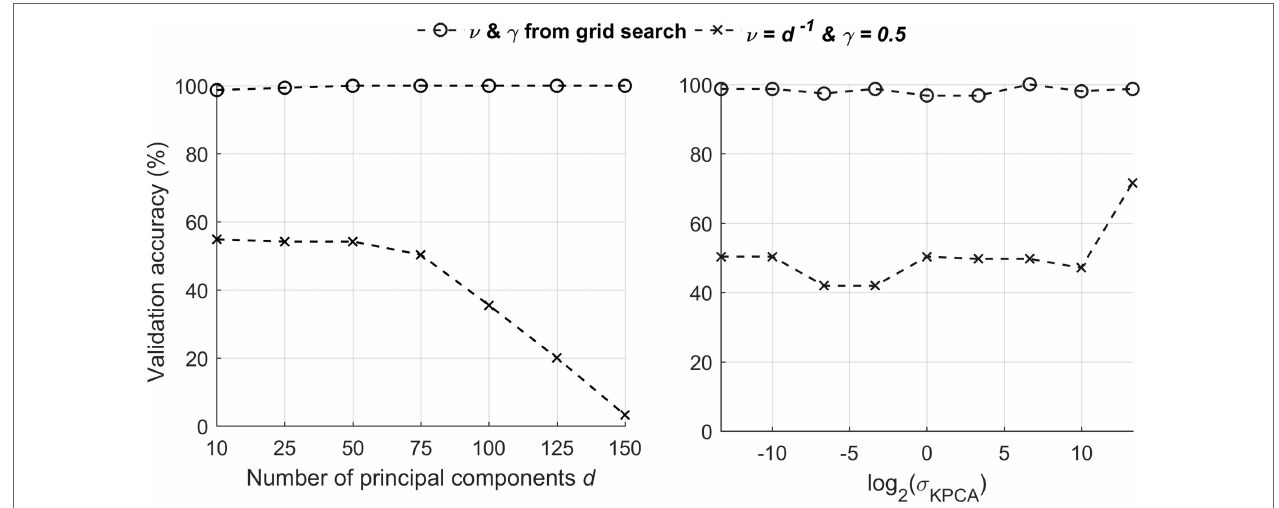
FIGURE 6 | Variation in cross-validation accuracy for different d and σ KPCA for selected (left) and fixed (right) γ and ν